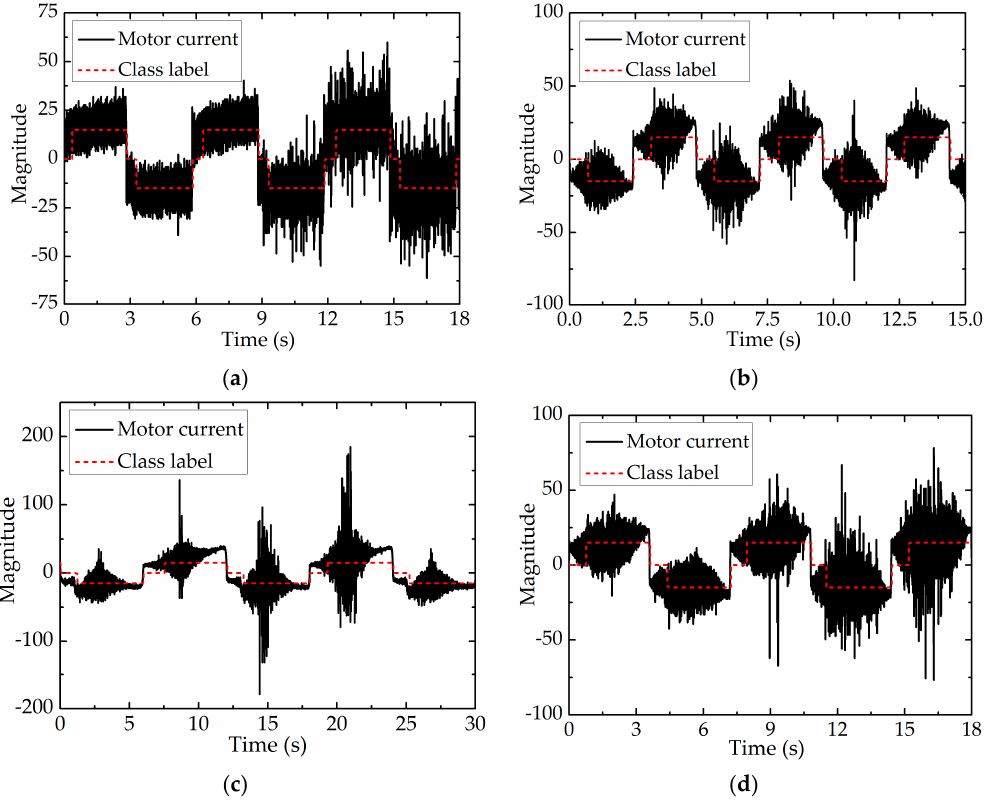
Figure 12. The classification effect of the movement stage when the motor runs in different motion patterns: ( a ) Uniform motion; ( b ) Uniform accelerated motion; ( c ) Variable accelerated motion; ( d ) Sinusoidal wave motion.